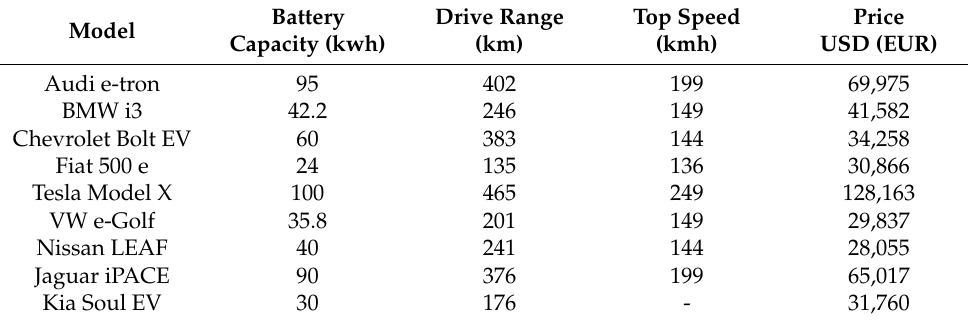
Table 3. Comparison of electric vehicles’ different parameters.